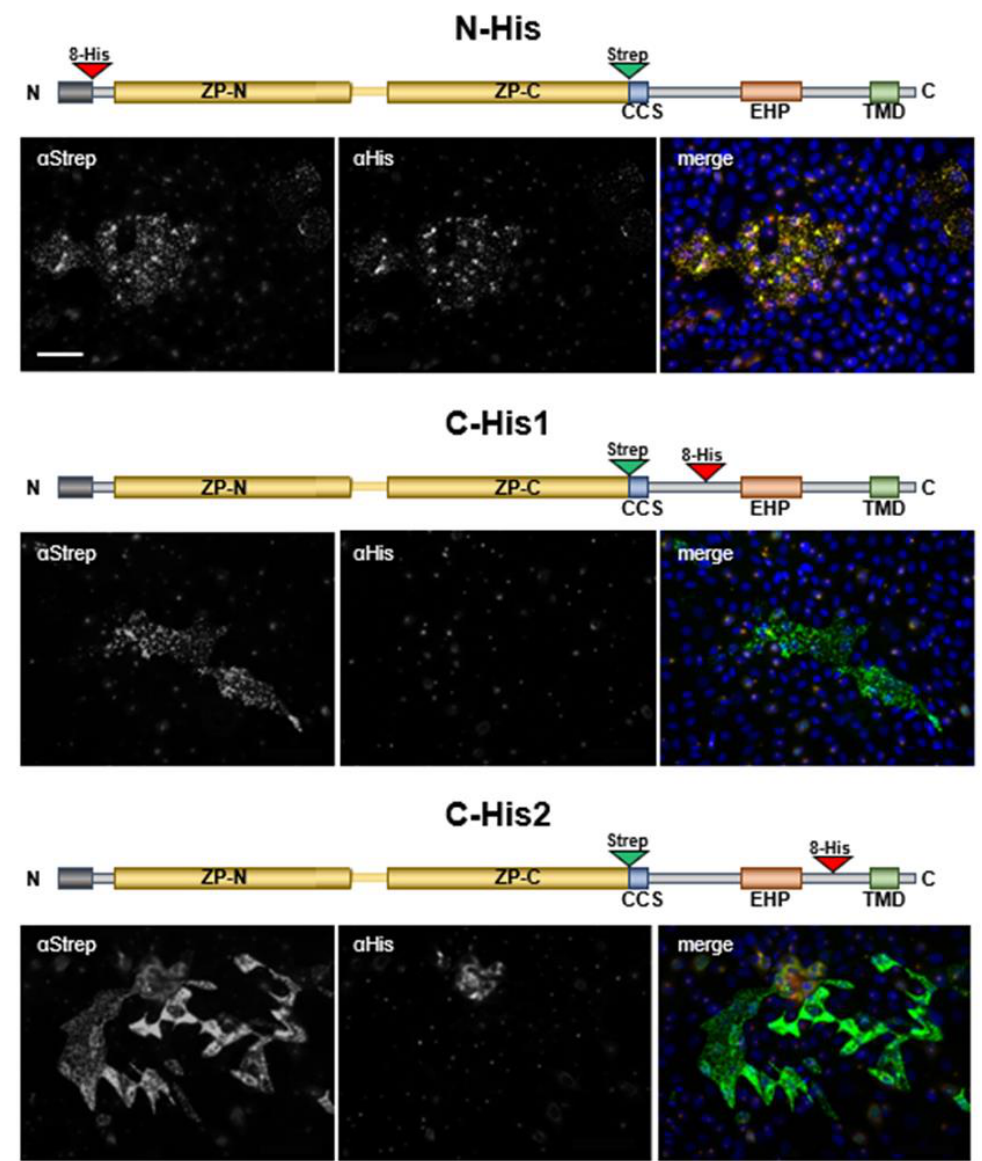
Figure 5. The EHP motif is lost upon ZPLD1 maturation and assembly into filaments. Immunofluorescence analysis on MDCK cells stably expressing N- and C-terminally tagged ZPLD1. A schematic representation of each tagged isoform is shown above the respective immunofluorescence panel. ZPLD1 structure is depicted as before. The EHP motif is indicated as an orange box, the position of 8xHis and Strep-tags as red and green triangles, respectively. Immunofluorescence analysis was carried out on unpermeabilized PFA-fixed cells that were stained for the His-tag and the Strep-tag simultaneously. In the merged picture, the Strep-tag signal is shown in green whereas the 8xHis-tag signal is shown in red. ZPLD1 polymers are positive for both antibodies when the 8xHis-tag is present at the N terminus (N-His). However, the His epitope not detectable when located downstream of the CCS, either before (C-His1) or after (C-His2) the EHP motif. These data suggest that the EHP sequence is lost in polymeric ZPLD1 proteins. Bar, 50 µ